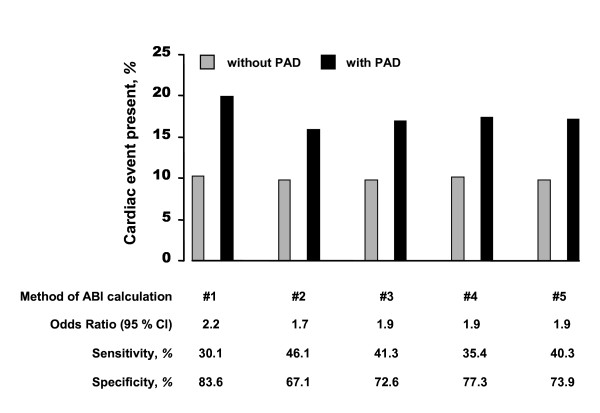
Association between PAD and history of cardiac event using odds ratios (OR). PAD was defined by an ABI value < 0.9 or clinical evidence of PAD, while history of cardiac event was evident after myocardial infarction or coronary revascularisation. OR, sensitivity and specificity are shown for the different modes of ABI calculation.  Sensitivity and specificity are given for the 'detection' or 'exclusion', resp., of a history of cardiac events.